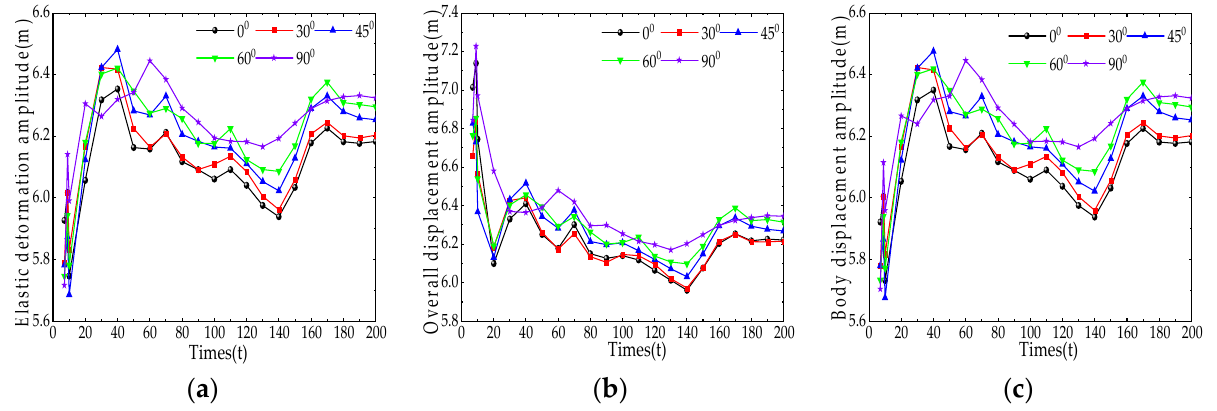
Figure 14. Magnitude of vertical displacement under waves with different incidence rules. ( a ) Elastic deformation; ( b ) Total displacement; ( c ) Rigid displacement.